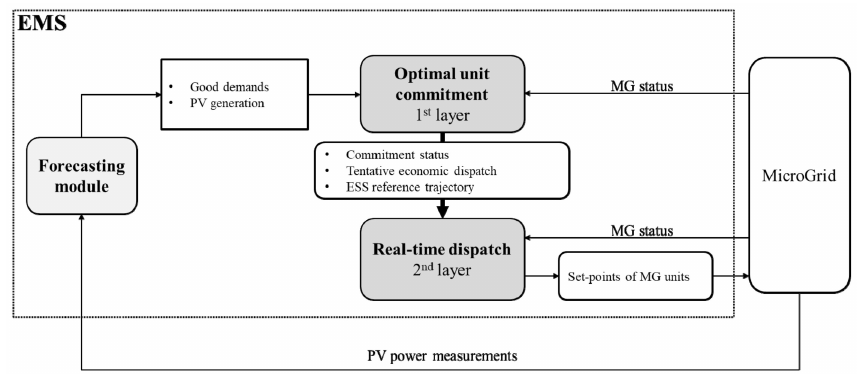
Figure 2. Architecture and information flow of the proposed two-layer energy management sys- tems